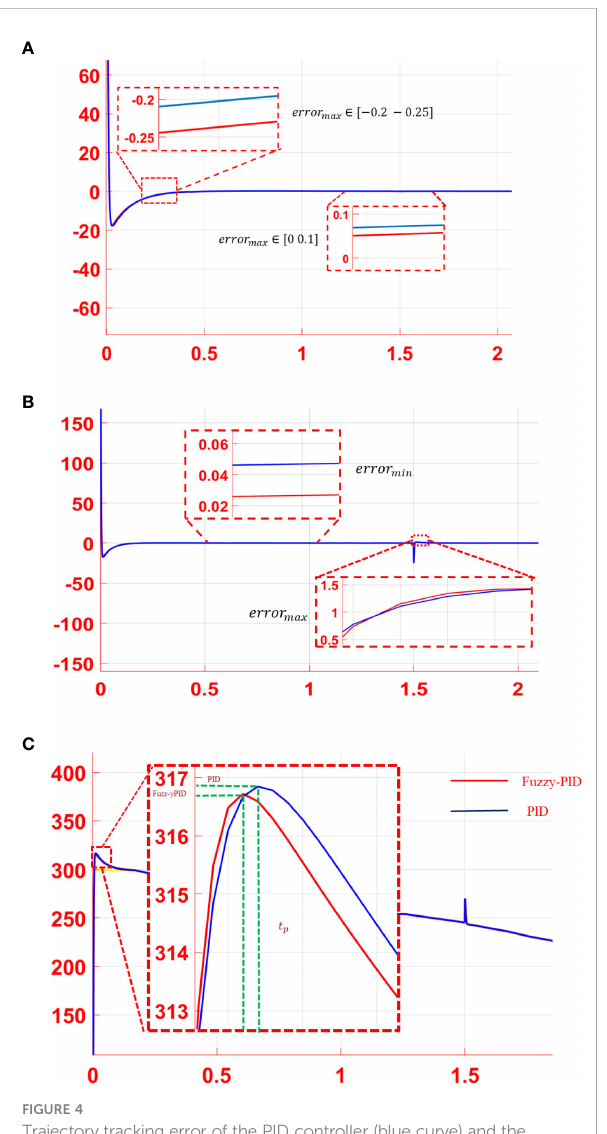
FIGURE 4 Trajectory tracking error of the PID controller (blue curve) and the fuzzy PID controller (red curve). (A) Tracking error without disturbance. (B) Tracking error with step signal disturbance. (C) Control performance analysis with step disturbance.